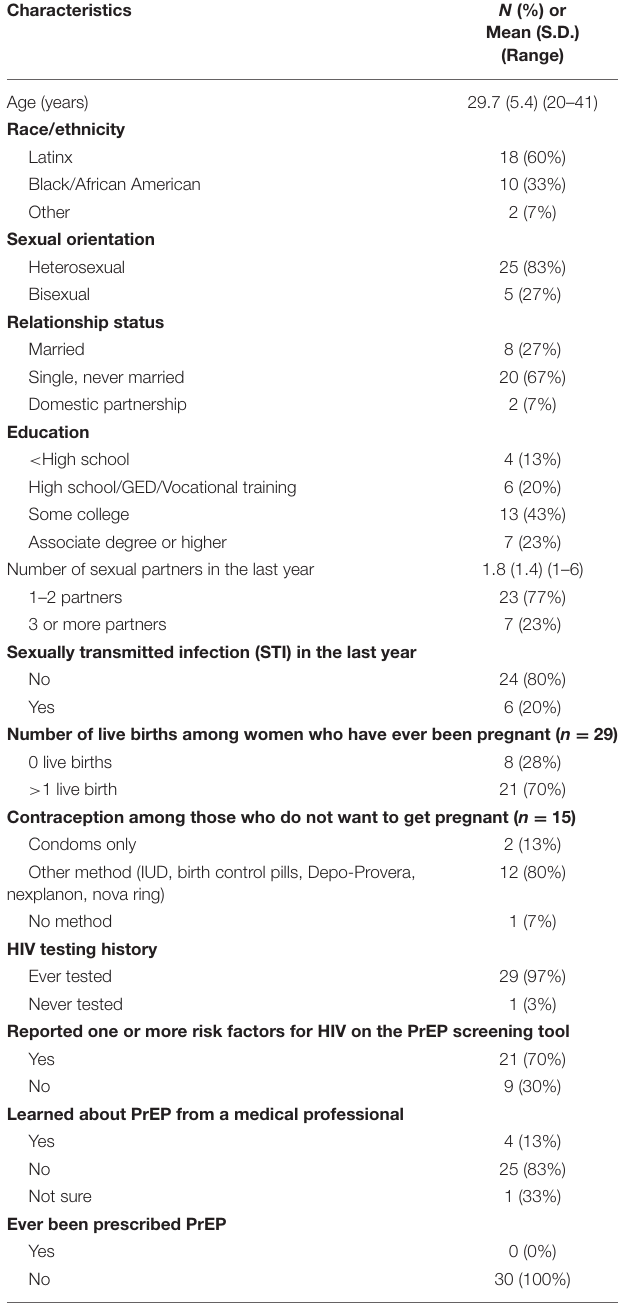
TABLE 1 | Baseline characteristics of the participants interviewed in the study.